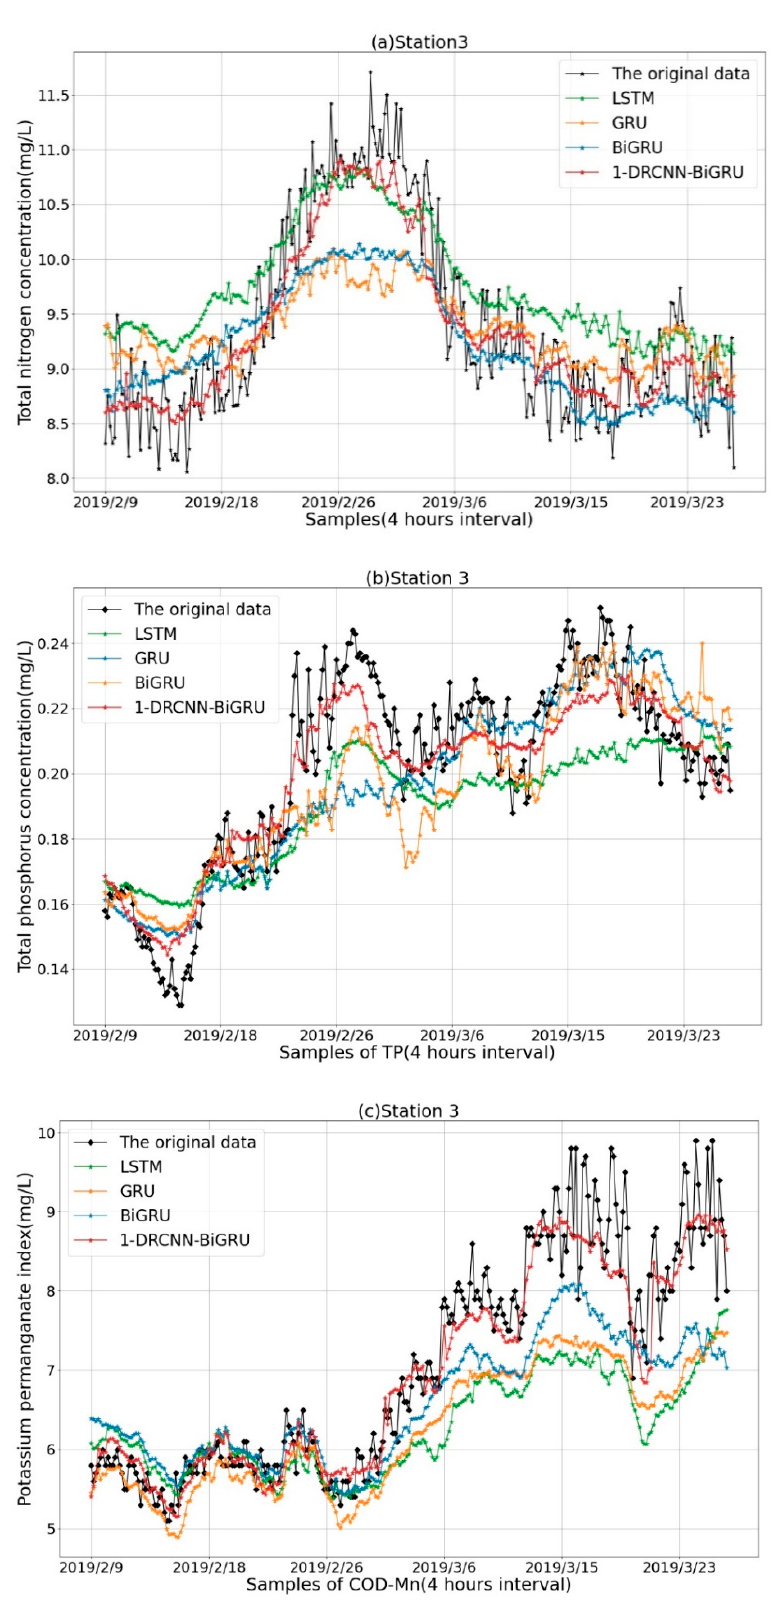
Figure 9. ( a ) Prediction results of total nitrogen (TN) in station 3. ( b ) Prediction results of total phosphorus (TP) in station 3. ( c ) Prediction results of potassium permanganate index (COD-Mn) in station 3.